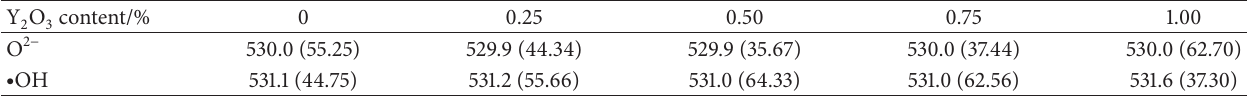
O -ZnO complex oxides contained different Y 2 3